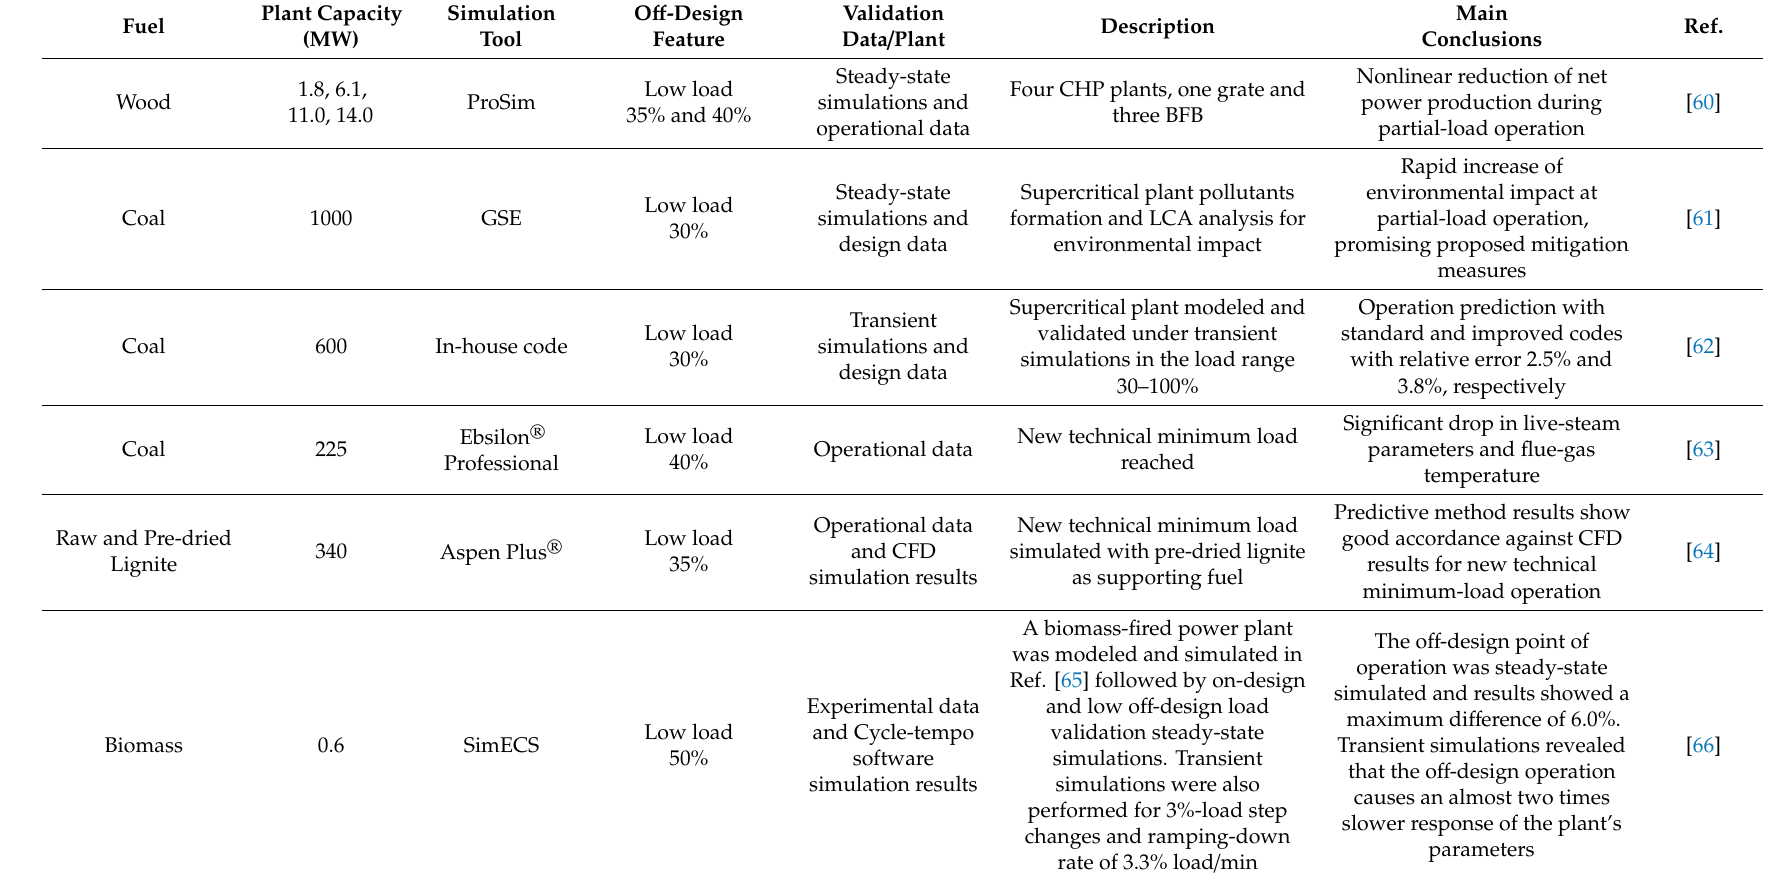
Table 2. Summary of power plants o ff -design operation